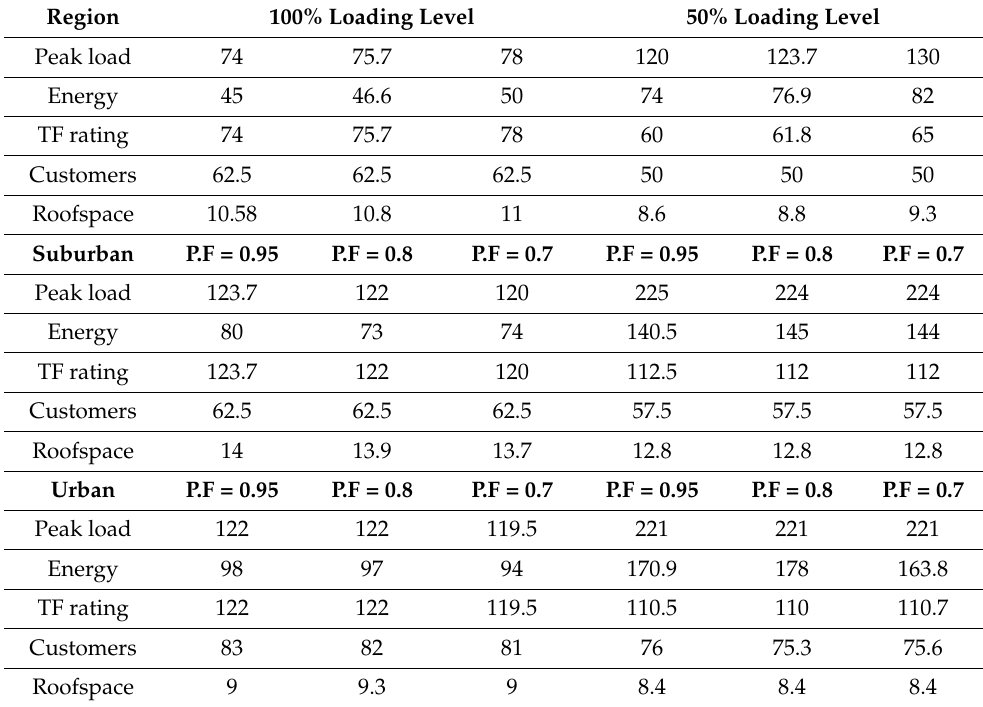
Table 7. The HC variation based on changing load power factor for 100% and 50% loading levels for balanced PVs in rural, suburban, and urban regions.